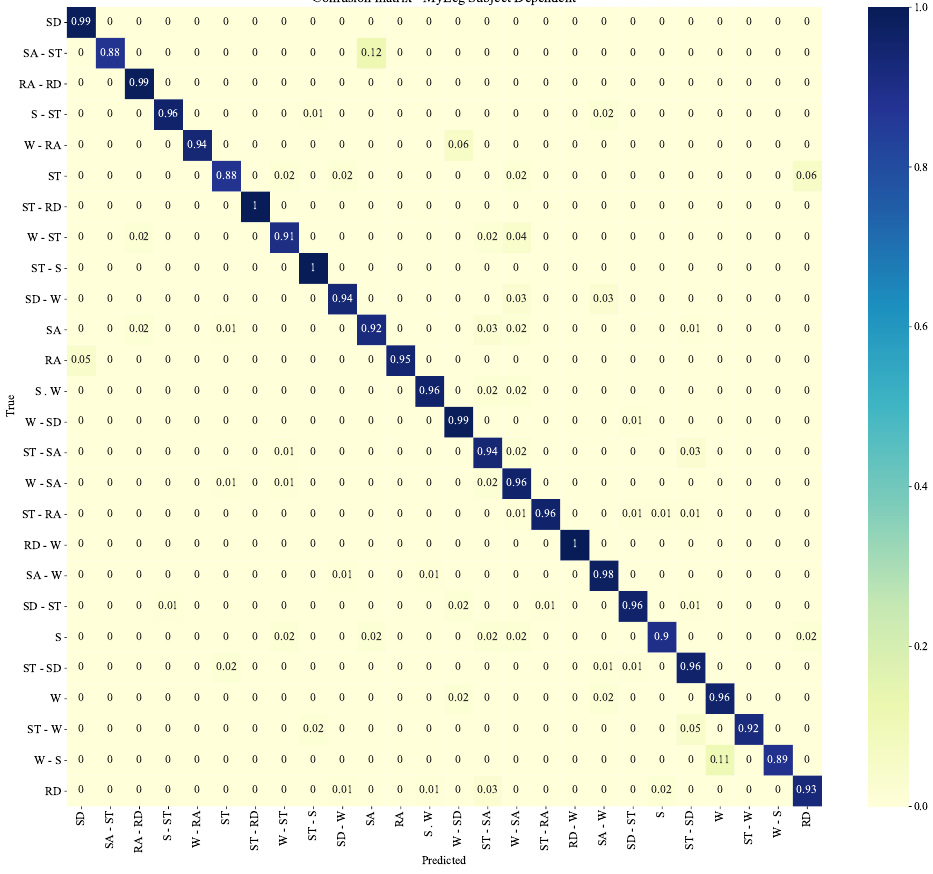
Figure 12. Confusion matrix for a MyLeg subject dependent scenario on the CNN- LSTM